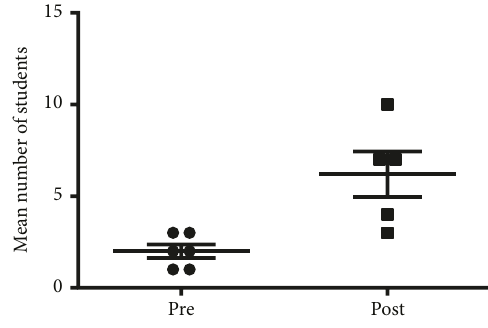
Figure 1: Mean number of students per six months enrolled in rheumatology elective in the time periods prior to and subsequent to development of the Rheumatology Interest Group.